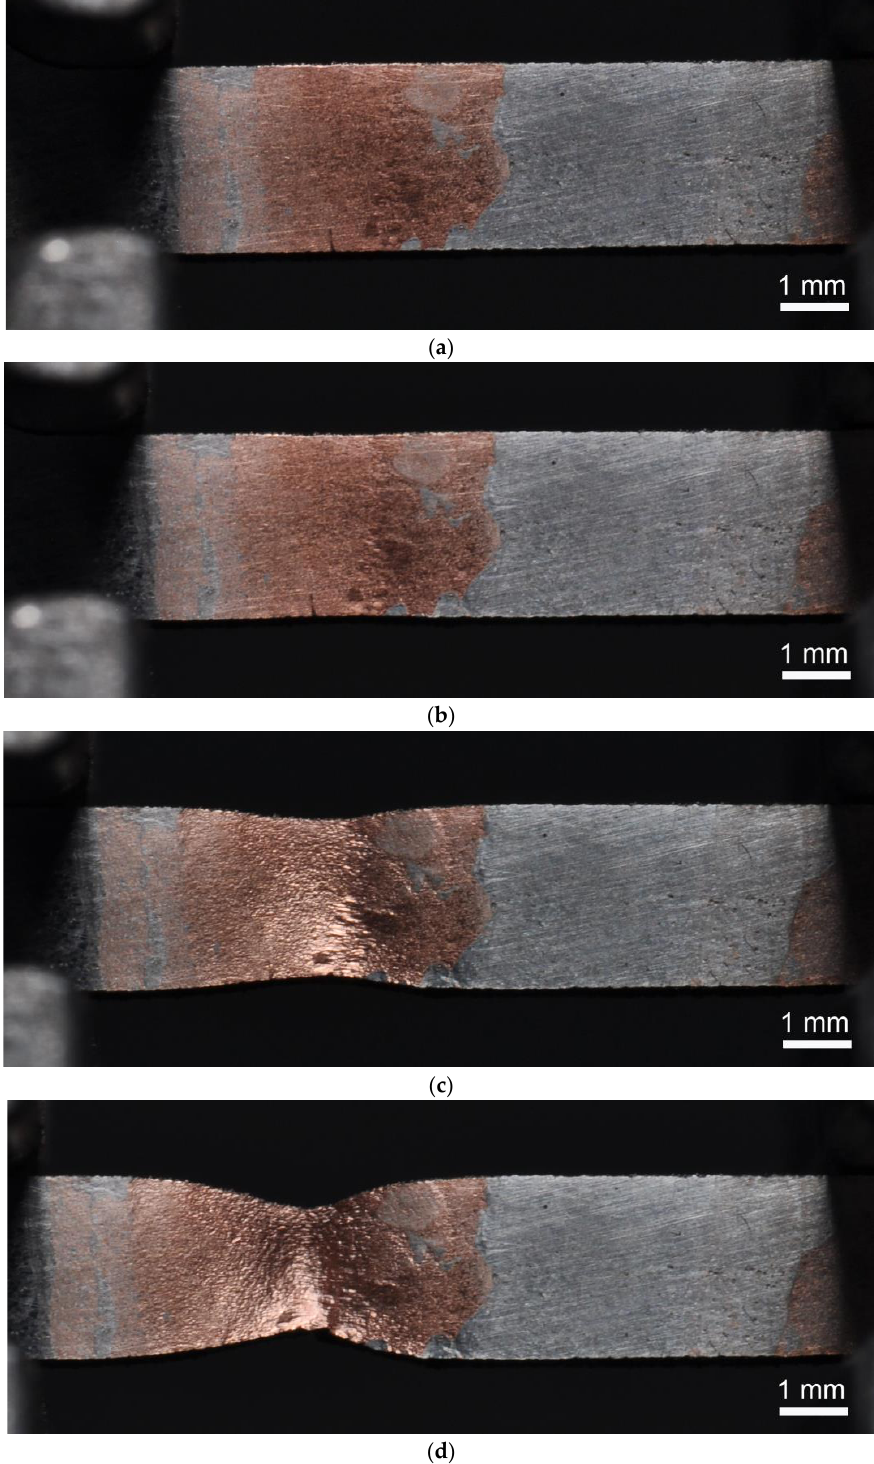
Figure 6. Macrophotographs taken under tension of a “copper-steel” specimen at different values of strain: ( a ) ε ≈ 0; ( b ) ε ≈ 0.07; ( c ) ε ≈ 0.15; ( d ) ε ≈